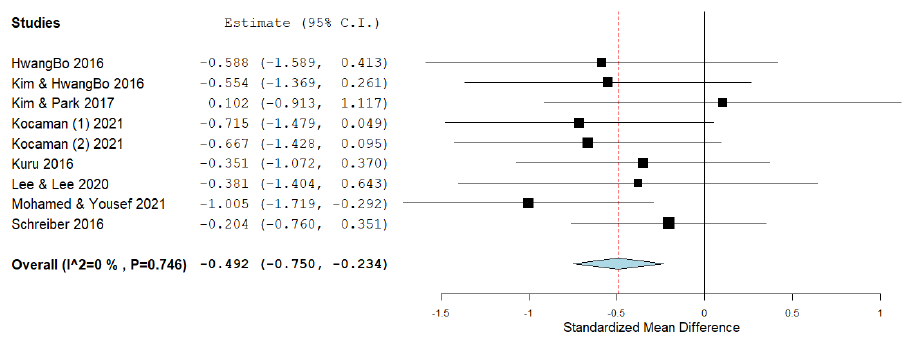
Figure 4. Effect size for the outcome Cobb angle.